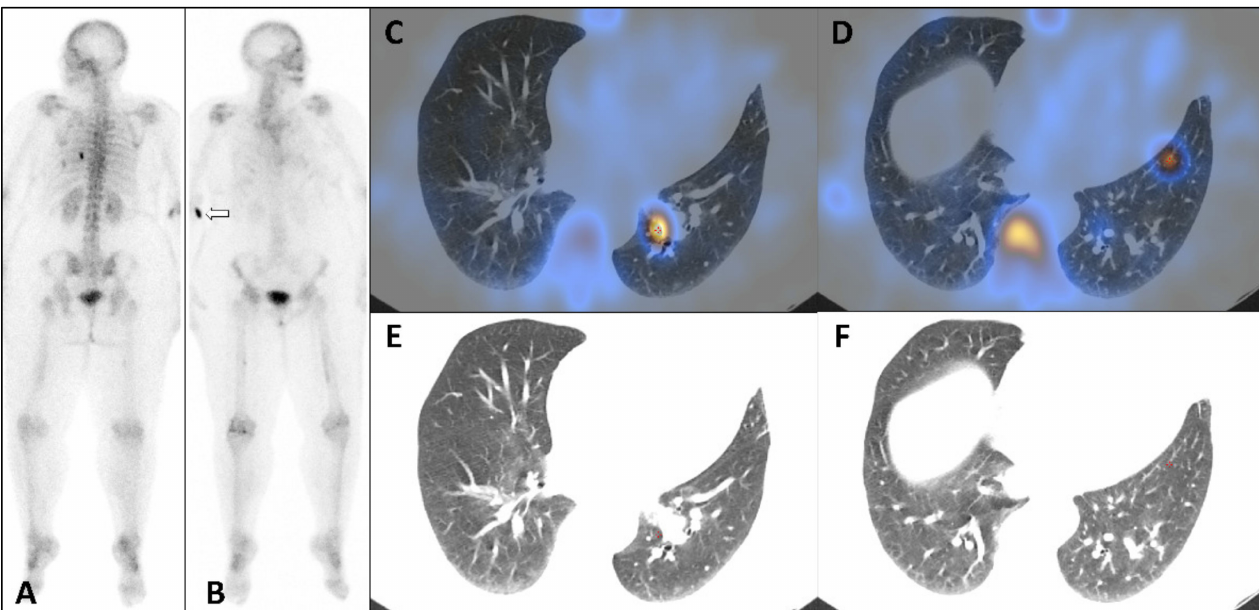
Figure 1. Whole body bone scan: posterior view ( A ), anterior view ( B ), axial SPECT-CT fused slices ( C , D ), correspondent CT slices ( E , F ). A 48-year-old woman was referred for a bone scan for assessment of bone metastasis from breast cancer. Posterior whole-body scan performed 2 h 30 min after IV injection of 825 MBq of 99m Tc-hydroxymethylene diphosphonate ( 99m Tc-HDP) highlighted two extra-osseous foci in projection of the 8th left rib (Figure 1A). Axial SPECT-CT fused slices showed an intense focal uptake in the left posterobasal lung segment close to proximal inferior lobe vessel (Figure 1C) and a less intense and more distal second focal uptake in the left anterobasal segment (Figure 1D). No abnormality was visible on correspondent CT slices (Figure 1E,F). Bone metastasis were limited to sternal body and left femoral diaphysis with mild osteoblastic activity. The patient had predominant liver metastasis, and carried out a combined treatment with trastuzumab, pertuzumab, letrozole, denosumab, calcium carbonate, and vitamin D3. The patient performed a contrast CT scan on the same day, thus, iobitridol was injected between 99m Tc-HDP intravenous injection and bone scan images acquisition. Fine helical slices showed no abnormality and especially no nodule or micronodule in the left lung. In order not to miss out a pulmonary embolism, ventilation/perfusion scintigraphy was performed five days later (Figure 2A,B), showing no significant perfusion defect. Eight months later, the follow-up bone scan showed no lung abnormality (Figure 2C,D), suggesting a non-pathological